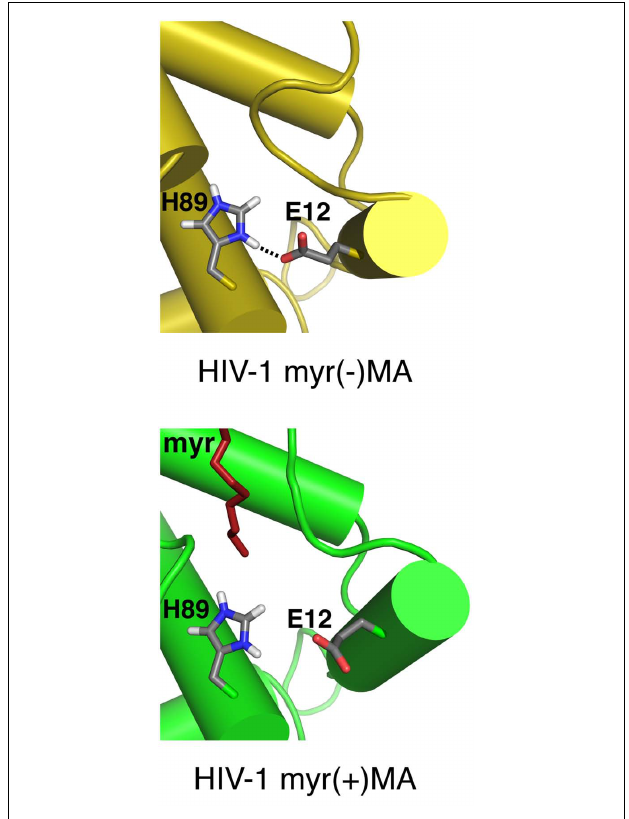
FIGURE 2 |The imidazole ring of His-89 forms a salt bridge with Glu-12(COO − ) in HIV-1 myr( − )MA but not in myr( + )MA.